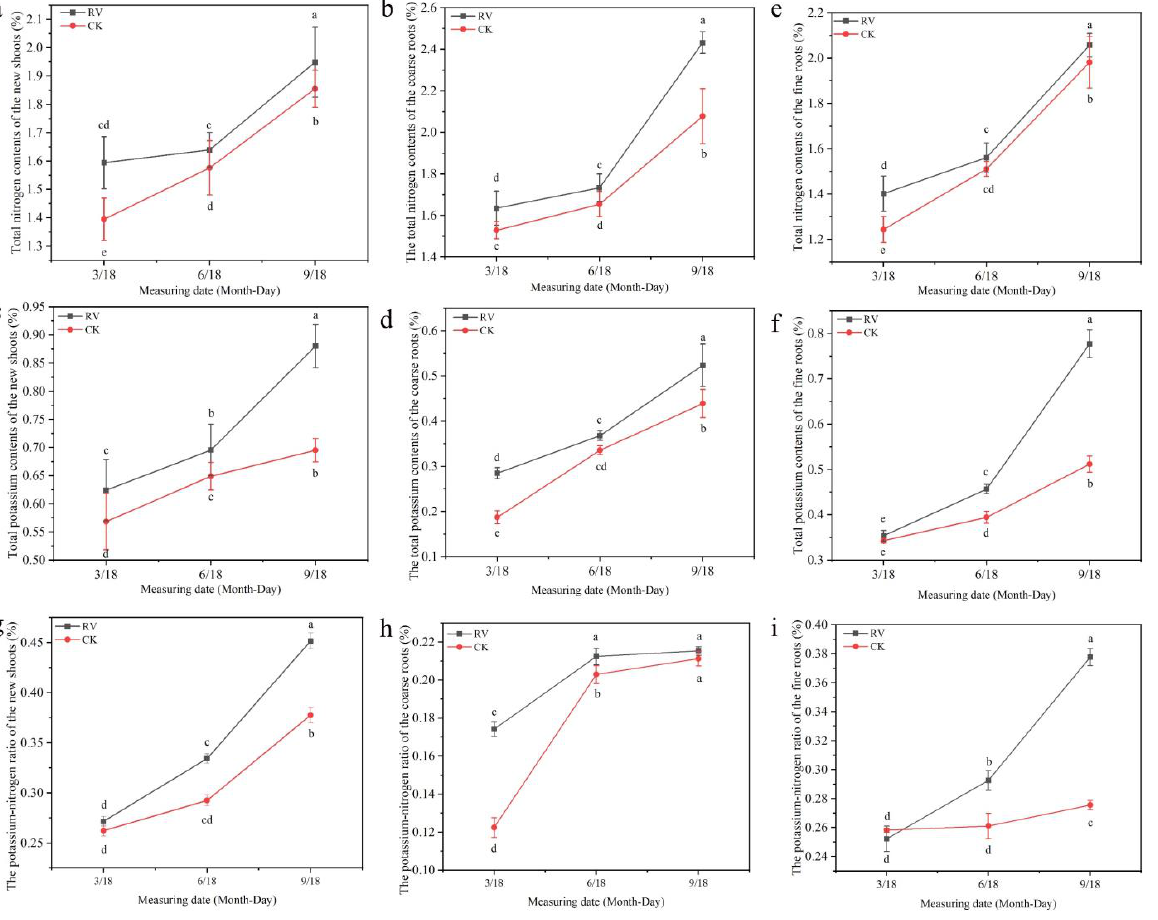
Figure 8. Effects of root-zone aeration on total potassium and total nitrogen contents in peach trees: ( a ) Total nitrogen contents of the new shoots. ( b ) Total nitrogen contents of the coarse roots. ( c ) Total nitrogen contents of the fine roots. ( d ) Total potassium contents of the new shoots. ( e ) The total potassium contents of the coarse roots. ( f ) Total potassium contents of the fine roots. ( g ) The potassium – nitrogen ratio of the new shoots. ( h ) The potassium – nitrogen ratio of the coarse roots. ( i ) The potassium – nitrogen ratio of the fine roots. Each point represents the mean ± standard error ( n = 3). Different lowercase letters indicate significant differences between treatments ( p < 5%, two-way ANOVA). 4. Discussion The root system is the link between the plant and the soil. A healthy soil environ- ment can promote the development of the root system which, in turn, promotes the growth of plants [36]. The results of this study showed that root-zone aeration could maintain the soil oxygen content throughout the growing season at levels substantially higher than that of the control (Figure 2a,b). The root-zone aeration changed the soil nu- trient contents in the root zone; the alkali-hydrolyzable nitrogen content, the soil organic matter content, and the available potassium content increased (Figure 2c – e); at the same time, the soil microbial species changed significantly (Figure 3). This may be because the soil nutrient contents are related to the soil microbial activity, soil enzyme activity, and nutrient uptake of plant roots. Previous research has found that under root-zone aeration treatment, changes in the soil gas environment take place, and the concentrations of O 2 and CO 2 in the soil change, altering the metabolic activity of microorganisms [37,38]. An